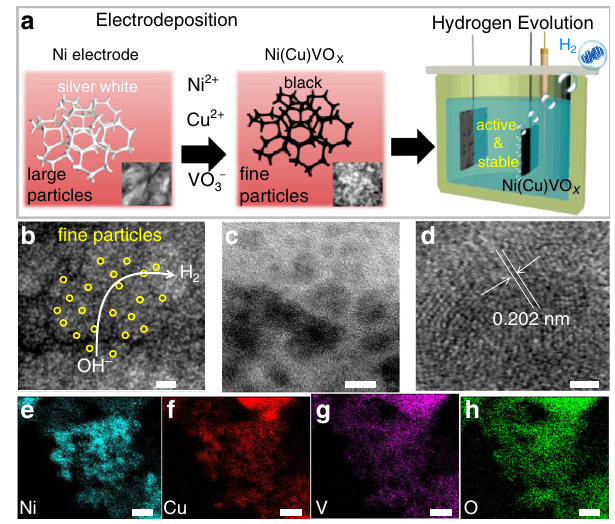
Fig. 1 Sample preparation and morphology of the Ni(Cu)VOx electrode. a Schematic to prepare the Ni(Cu)VOx electrode for HER